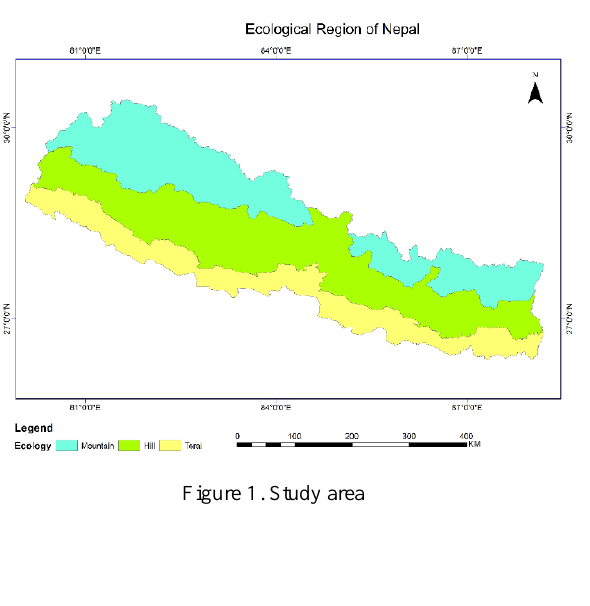
Figure 1. Study area